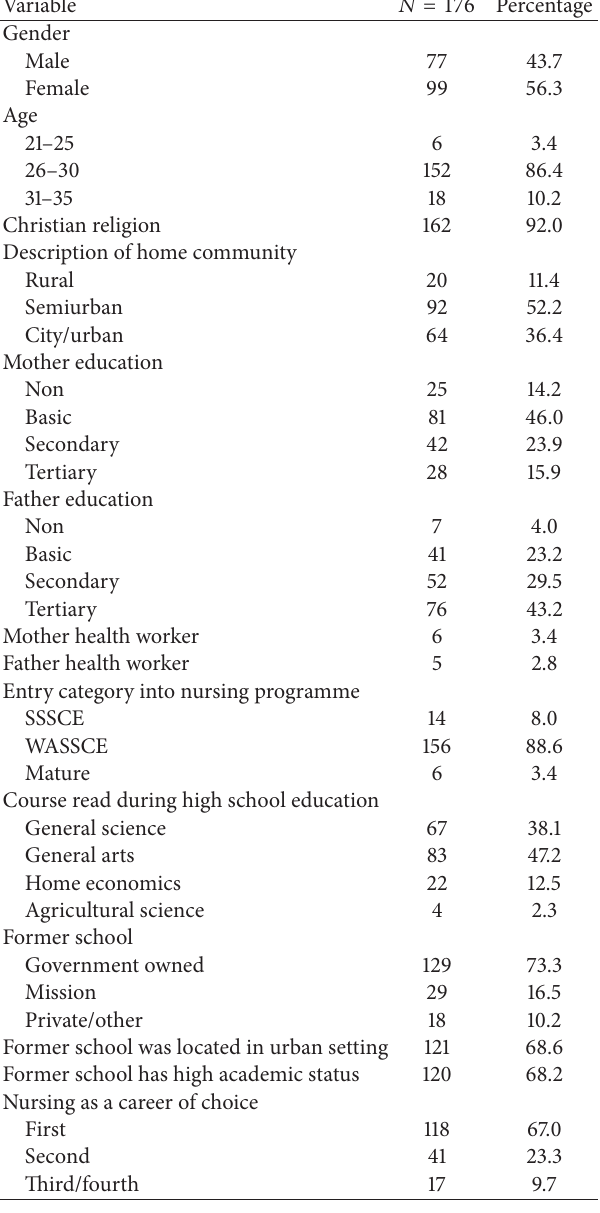
Table 1: Description of background characteristics and previous